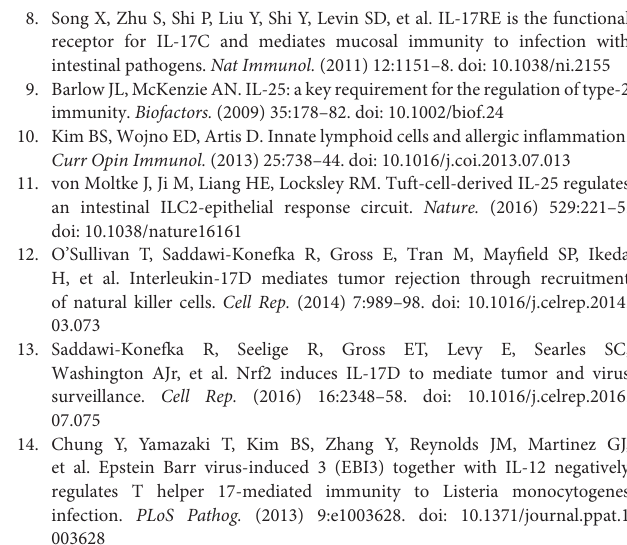
Supplementary Figure 1 | Measurement of inflammatory molecules after LPS-induced endotoxin shock. Mice were injected intraperitoneally with 5 mg/kg of LPS. After LPS injection, survival was monitored and serums were collected at the indicated time points. The concentrations of IL-6, CXCL-1, TNF α , IFN γ in serum from WT mice ( n = 6) or Il17d − / − mice ( n = 5) were measured by ELISA. Supplementary Figure 2 | Bacterial burden at an early time point and challenge of listeria strain without OVA. (A) Bacterial burden at an early time point was similar between WT and Il17d − / − Mice. WT ( n = 5) or Il17d − / − mice ( n = 4) were intravenously infected with 1 × 10 4 LM-OVA on day 0, and bacterial burden was analyzed in the spleen and liver on day 3. Data are from two experiments. (B) Bacterial burden was reduced in Il17d − / − mice after infection with L. monocytogenes strain without OVA. Ten weeks old WT ( n = 4) or Il17d − / − mice ( n = 3) were infected with 1 × 10 5 L. monocytogenes ATCC strain 13932. Mice were euthanized on day 7 and bacteria burdens in the infected livers were measured. (C) Il17d − / − mice had increased survival following L. monocytogenes ATCC strain 13932 infection. Six weeks old WT and Il17d − / − mice were infected with 1 × 10 5 L. monocytogenes and monitored for survival ( n = 9 for WT mice; n = 8 for Il17d − / − mice). p = 0.016, log-rank test. Supplementary Figure 3 | Weight loss during influenza A virus infection was similar between WT and Il17d − / − mice in a RAG-deficient background. (A) Rag1 − / − × WT and Rag1 − / − × Il17d − / − mice were intranasal administrated with 13 PFUs of PR8 influenza A virus, and their body weights were measured every days. (B) Lung viral load was assessed via qPCR of influenza A HA RNA. Data are from two times